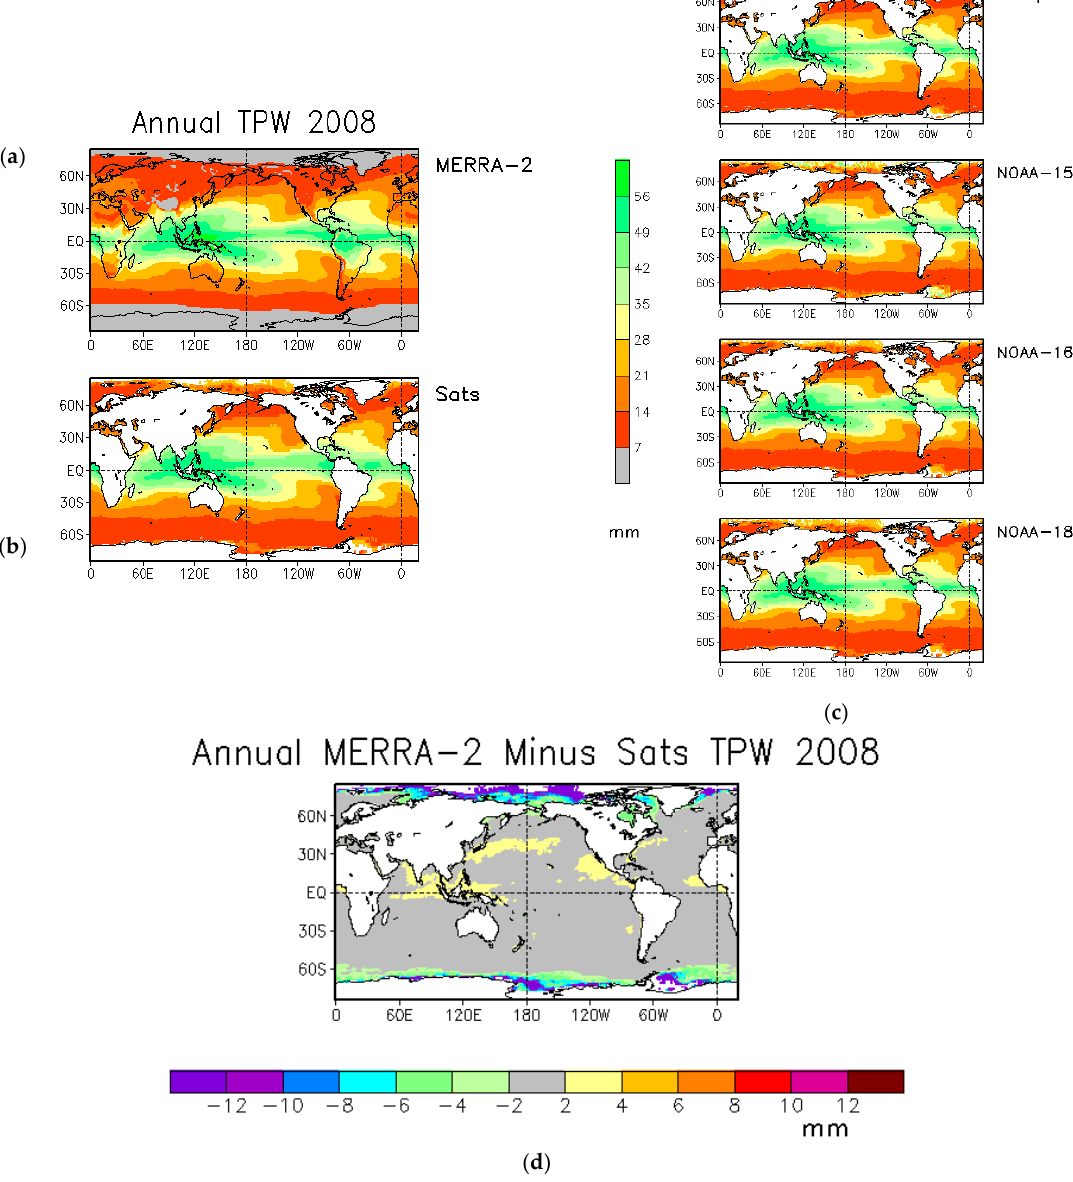
Figure 5. Annual total precipitable water for 2008 for MERRA-2 ( a ), HBC—all satellites ( b ), each individual satellite ( c ), and MERRA—minus all satellites ( d ).